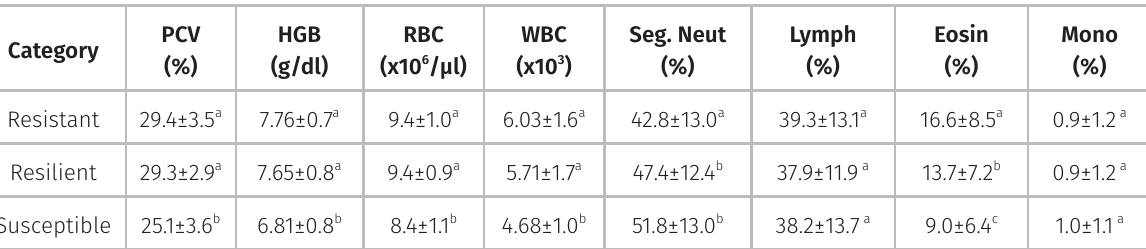
Table II. Means and standard deviations of packed cell volume (PCV), hemoglobin (HGB), red blood cells (RBC), white blood cells (WBC), segmented neutrophils (Seg Neut), lymphocytes (Lymph), eosinophils (Eosin) and